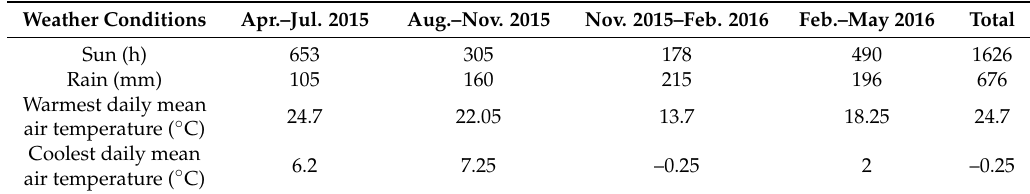
Table 1. Environmental conditions in central Oxford (Radcliffe Meteorological Station; latitude: 51.7614, longitude: − 1.2636) near the field site (Wytham Woods, UK; latitude: 51.7759, longitude: − 1.3379) for the four exposure periods in the duration of one